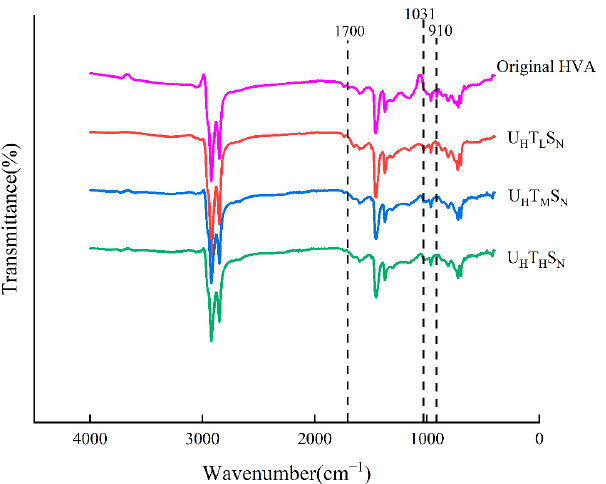
Figure 5. Variation of spectrum of different asphalt samples under different temperature levels.